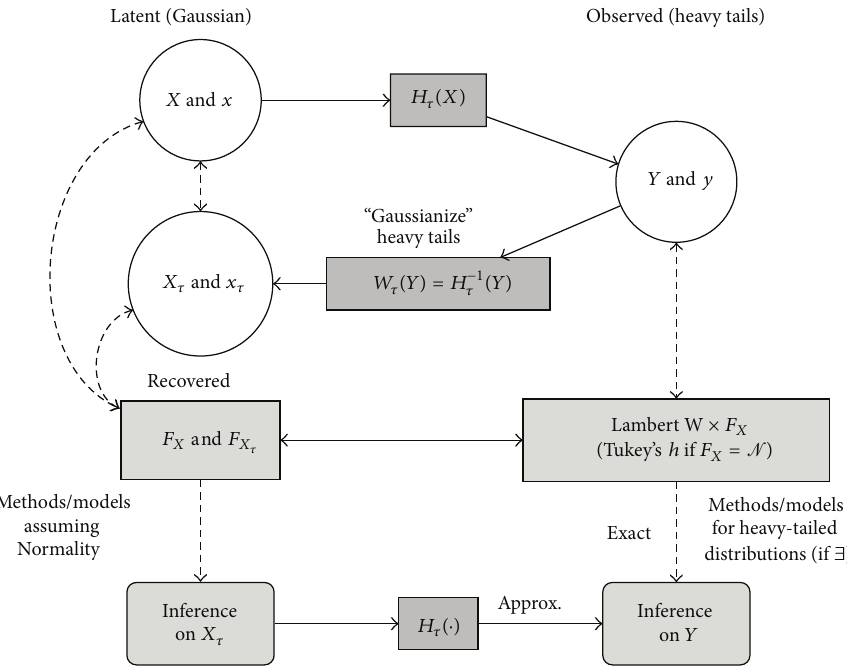
Figure 1: Schematic view of the heavy tail Lambert W × 𝐹 𝑋 framework. Latent input 𝑋 ∼ 𝐹 𝑋 : 𝐻 𝜏 (𝑋) from (6) transforms (solid arrows) 𝑋 to 𝑌 ∼ Lambert W × 𝐹 𝑋 and generates heavy tails (right) Observed heavy-tailed (2) use model M x 𝜏 , N of your choice (regression, time series models, hypothesis testing, etc.) for inference on to the original “heavy-tailed world” of y